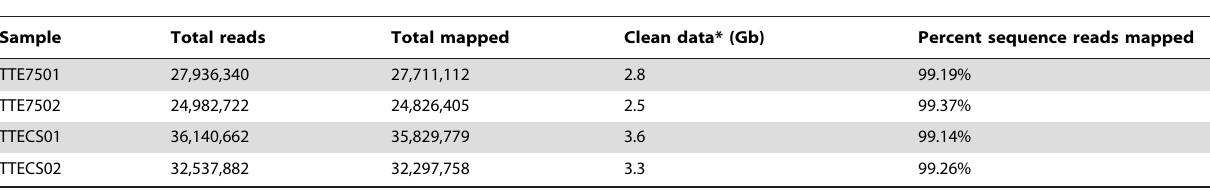
Table 1 . Summary of Illumina RNA-seq data.